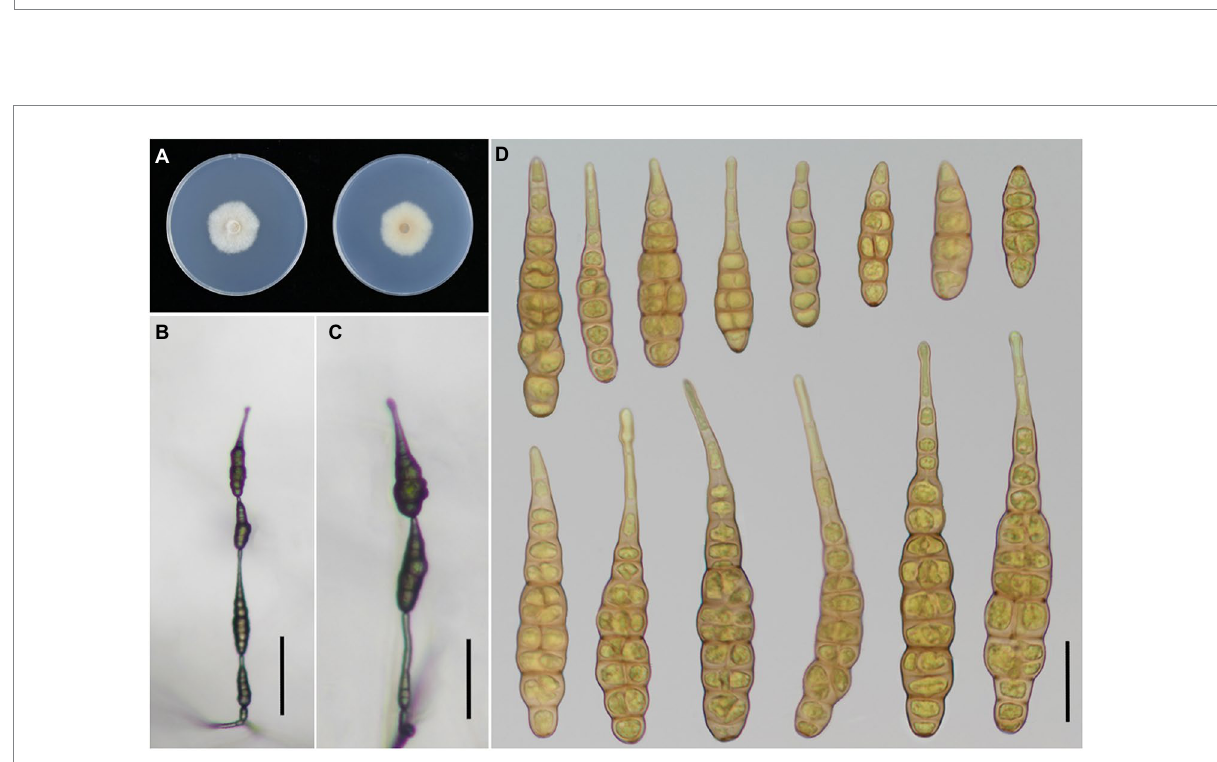
FIGURE 4 Morphology of Alternaria iridicola. (A ) Colony phenotype (on PDA for 7 days at 25 ° C); (B,C) Sporulation patterns (on PCA at 22 ° C); (D) Conidia Bars: B,C = 50 μ m; D = 25 μ m.